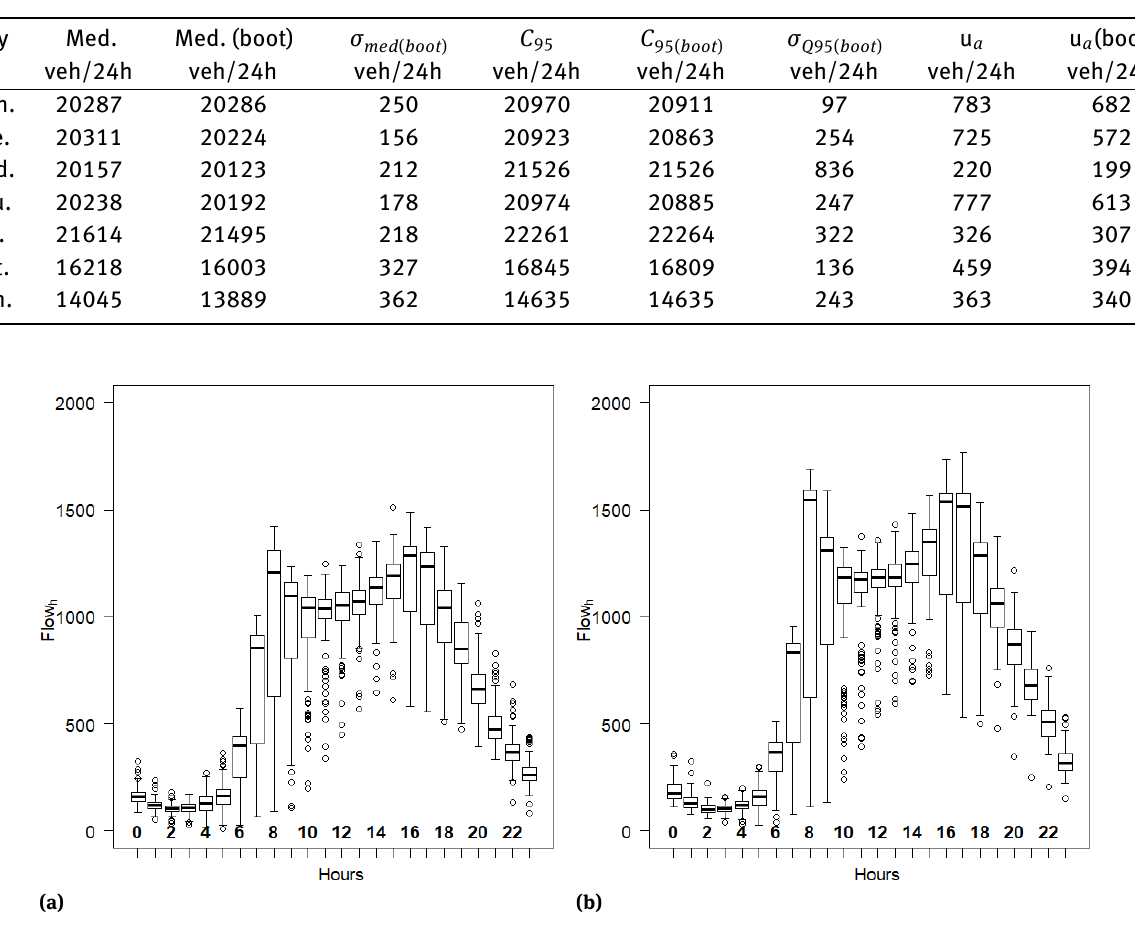
Table 2: A comparison of basic statistical measures of traflc volumes, determined by descriptive statistics and bootstrap method (boot) for all vehicles and for each day of the week in 2016